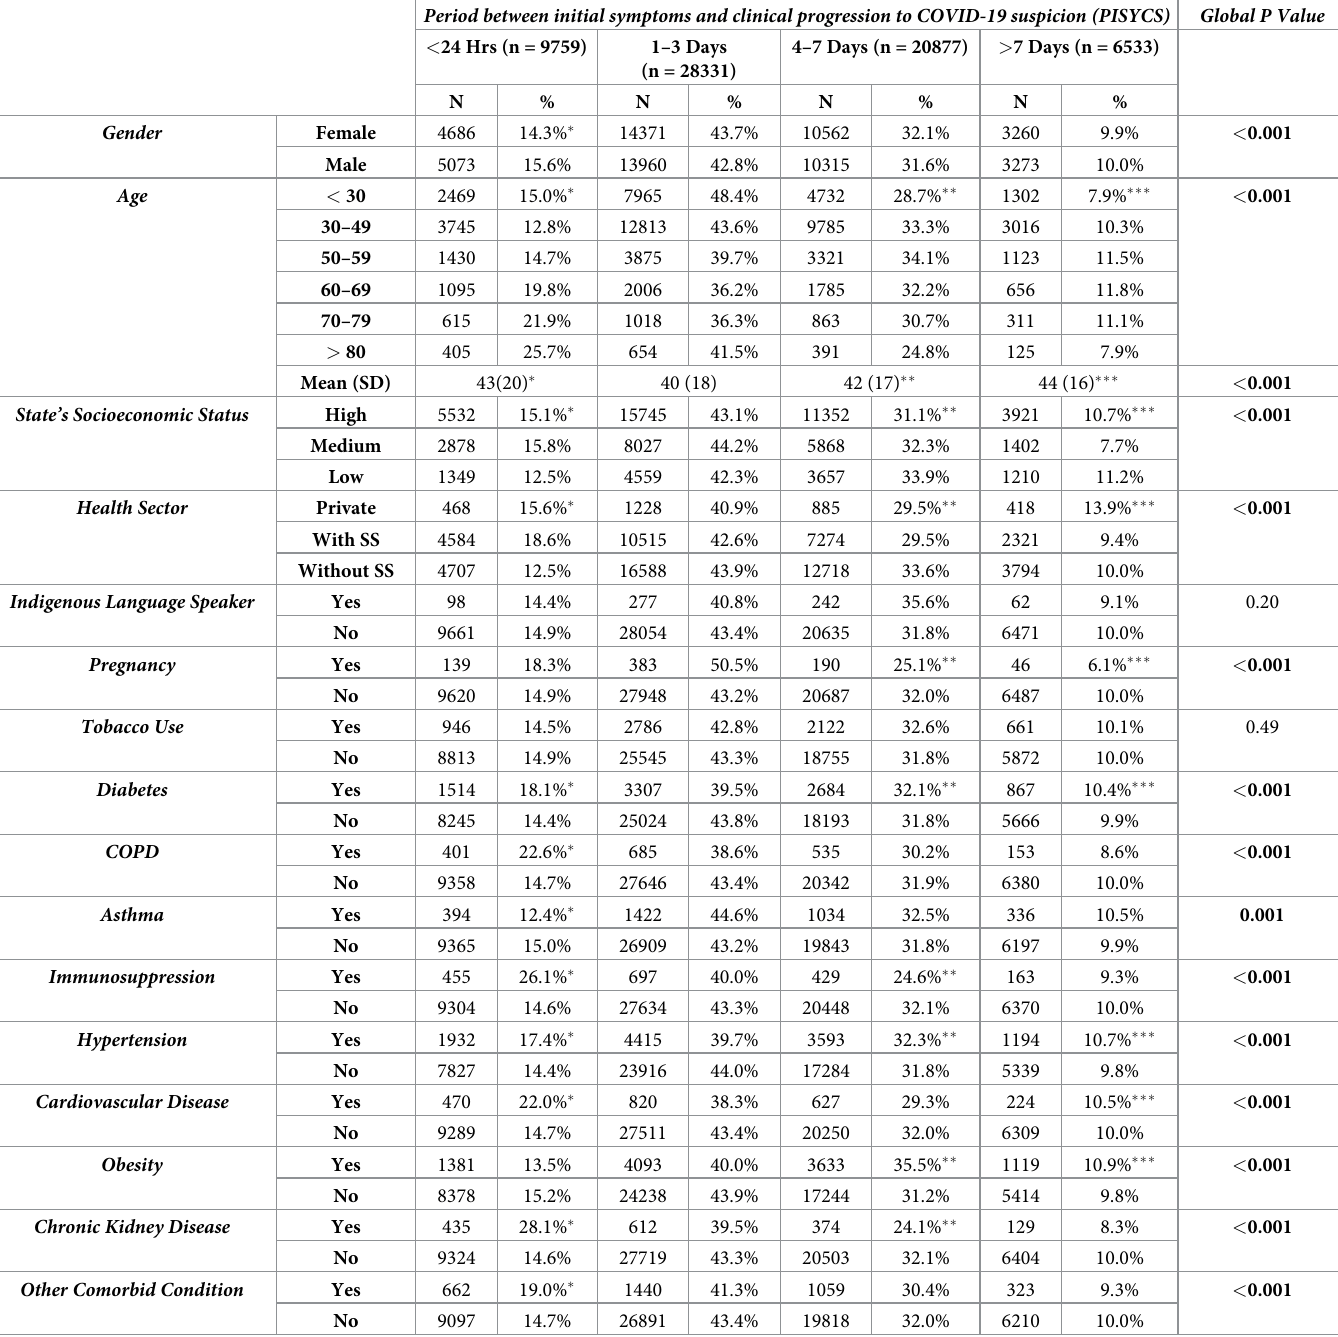
Table 1. Patient demographic characteristics according to period between initial symptoms and clinical progression to COVID-19 suspicion